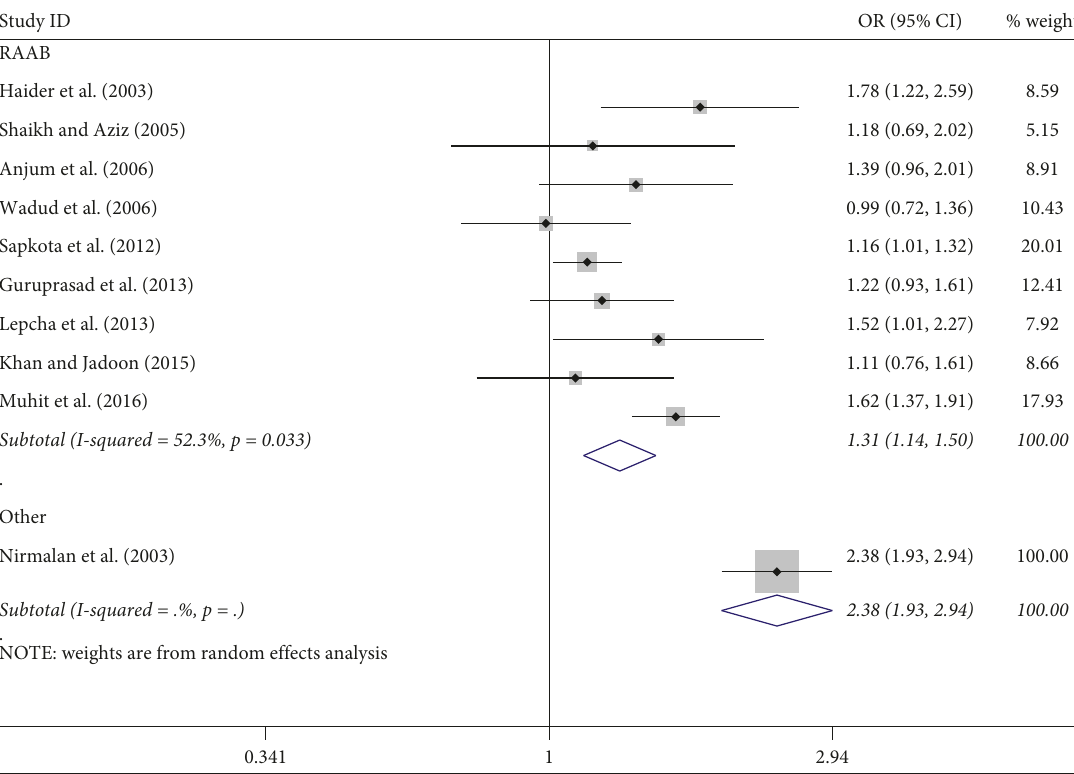
Figure 8: Subgroup analysis of CSC by design on an eye basis at visual < 3/60 level. CSC � cataract surgical coverage; OR � odds ratio; CI � confidence